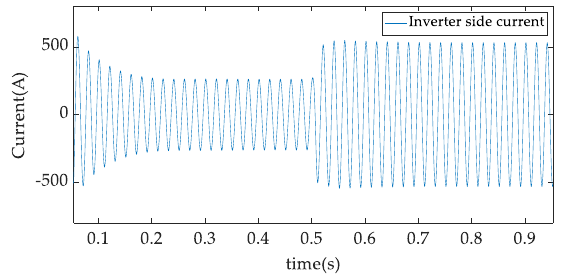
Figure 19. Current waveforms on inverter side.